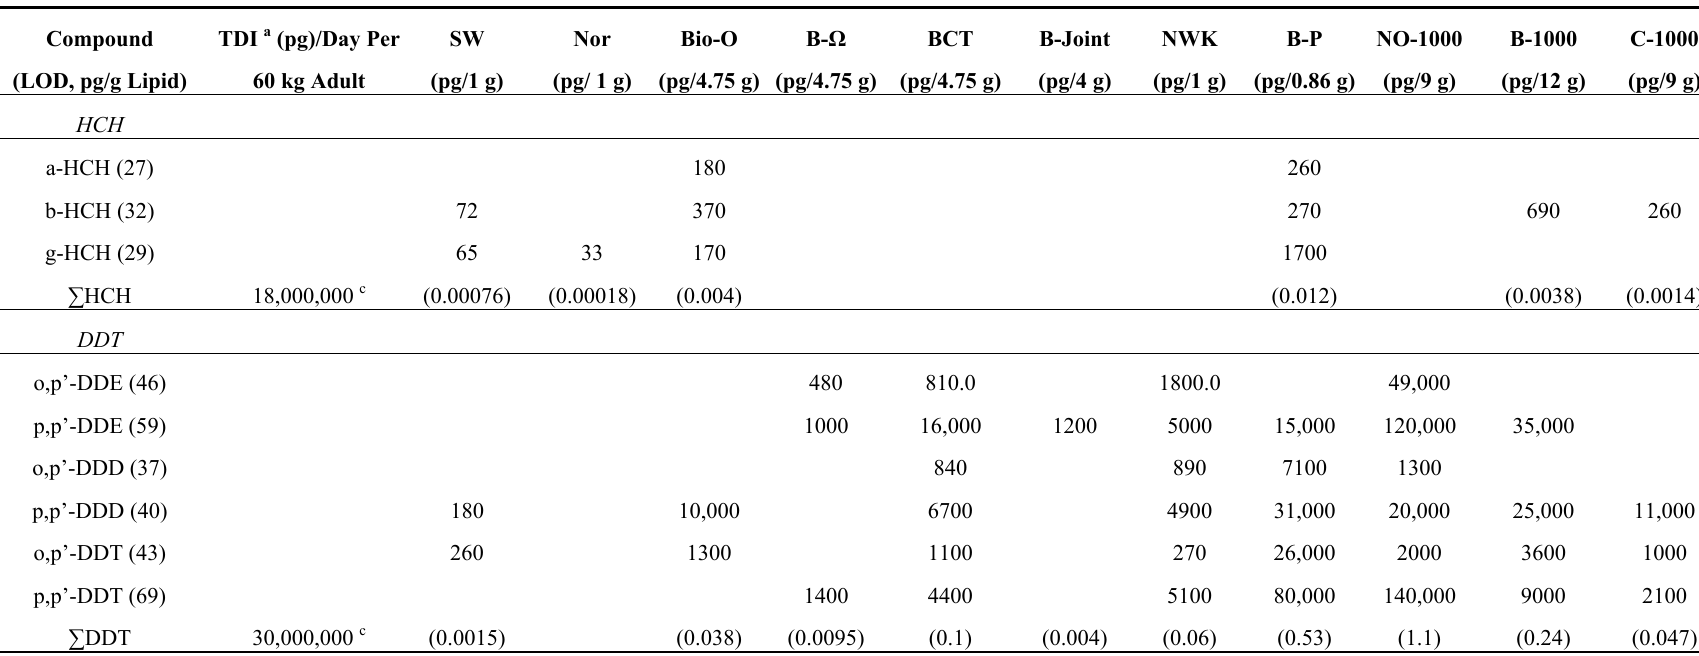
Table 4. Chemical burdens per maximum recommended daily dose (lipid); where relevant, corresponding TEQ (2005) and percent (%) of Tolerable Daily Intake (TDI). Values are presented to two significant figures. Blank squares indicate that values fell below the method level of detection (LOD), which are given as an average concentration for all 11 products (pg/g lipid), whilst grey squares indicate that corresponding congeners were not analysed for that product. Abbreviations used for oil products are: Swisse Krill Oil (SW); Norkrill (Nor); Bio-organics (Bio-O); Blackmores Omega ( B- Ω ); Bioceuticals (BCT); Blackmores Joint (B-Joint); Nature’s Way Kidsmart (NWK); Blackmores Pregnancy (B-P); Nature’s Own 1000 mg (NO-1000); Blackmore’s 1000mg (B-1000); Cenovis 1000 mg (C-1000). Capsules or subsamples from two separate batches of each product were pooled for each POP analysis, except for Blackmores Omega Liquid Fish Oil for which only a single batch number could be